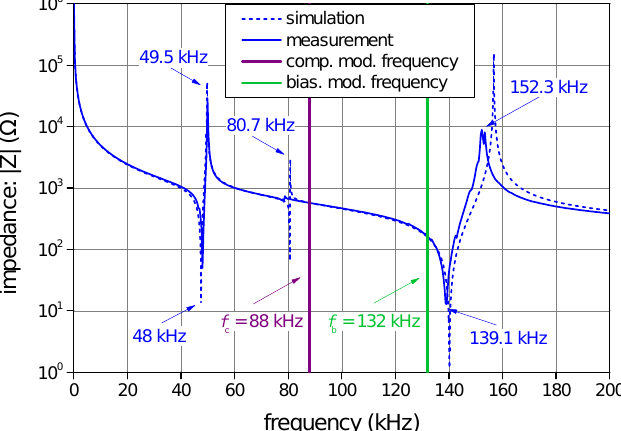
Figure 7. The frequency characteristics of the impedance of the employed PEM, with the biasing and compensation modulation frequencies marked in green and purple. The response was simulated using the finite element method and verified via experimental measurement.